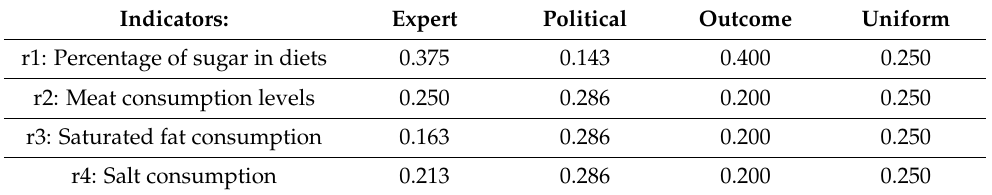
Table 12. Four weighting schemes, as defined within the food sustainability study [31]. Indicators: Expert